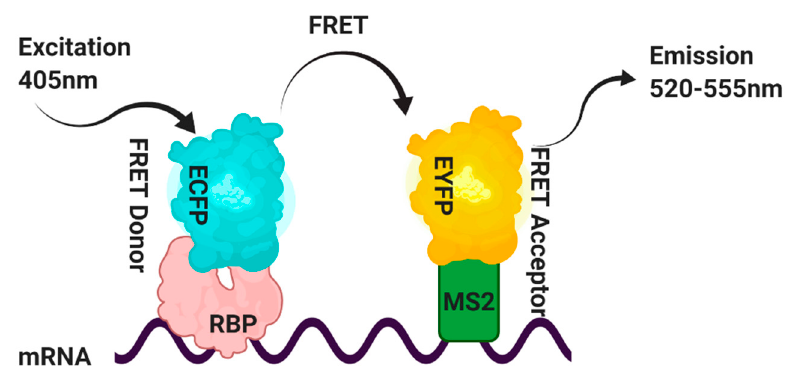
Figure 5. Schematic representation of the strategy utilized to visualize RNA–protein interactions in cells. Fluorescence resonance energy transfer (FRET) signals between the RNA-binding protein (RBP) (protein of interest) bound to the ECFP and MS2-EYFP pairs are detected by the acceptor photobleaching method. This method detects the de-quenched donor fluorophores in the presence of acceptors [62].